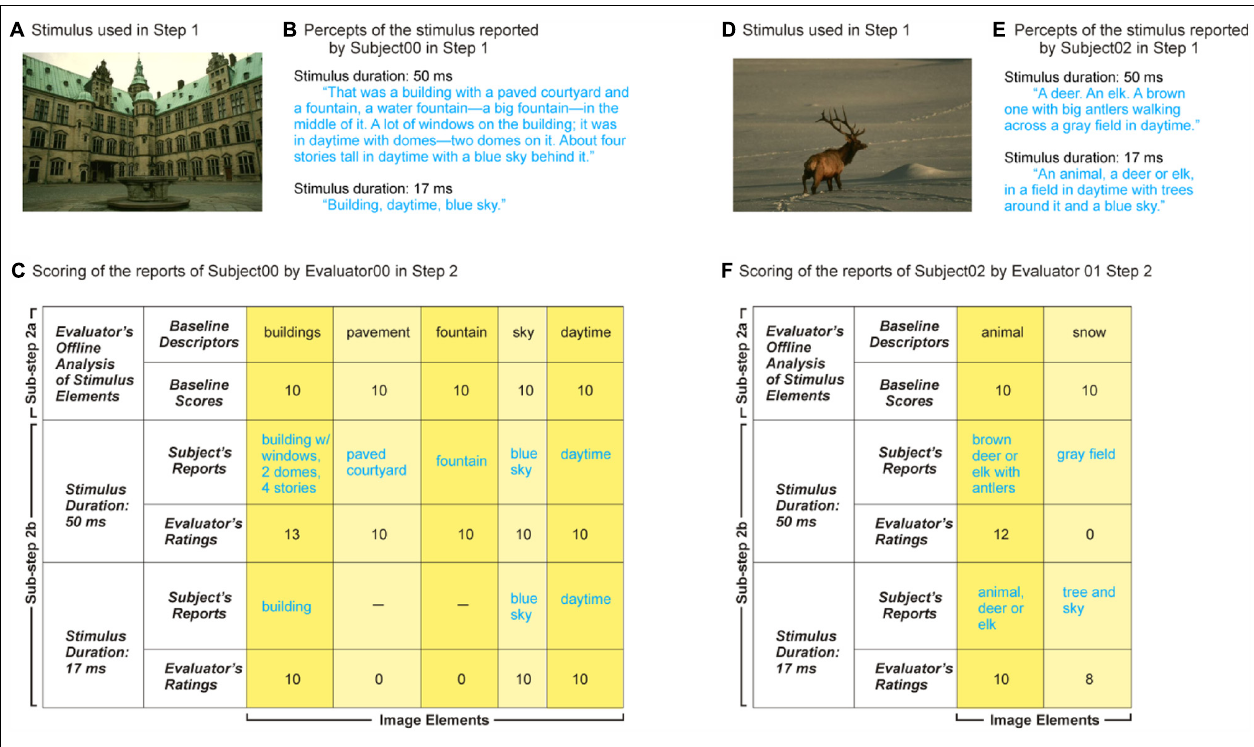
FIGURE 3 |Two instances of implementation of SDR steps 1 and 2. Panels A through C show the scoring of one set of verbal reports, and panels D through F show the scoring of a second, independent set. (A) Stimulus. Subject viewed the stimulus for 50 ms and 17 ms respectively in randomly interleaved trials, so that subject reports were paired across the experiment. Note even though each subject viewed the same stimulus twice, the longer viewing duration always preceded the shorter viewing duration, so as to counteract priming effects, if any (see text for